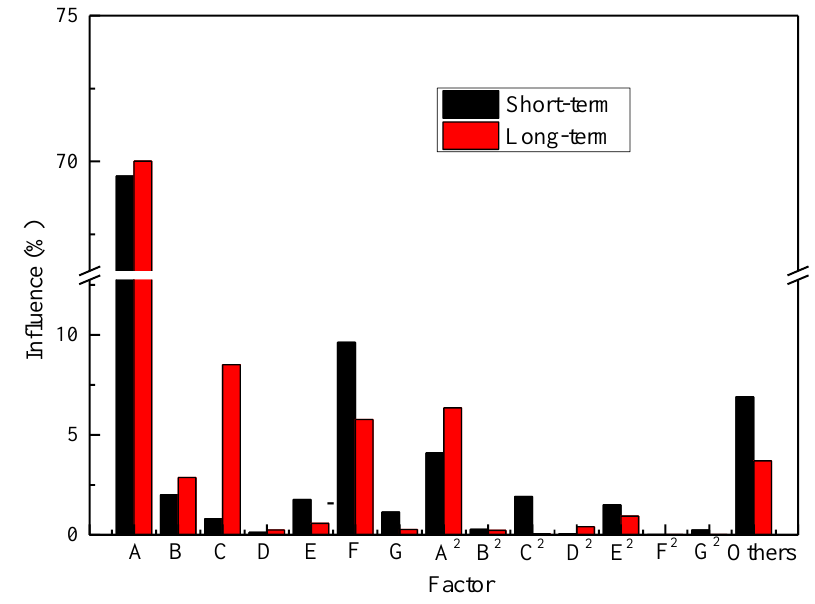
Figure 12. Influences of factors on GRR for short-term and long-term gas production.